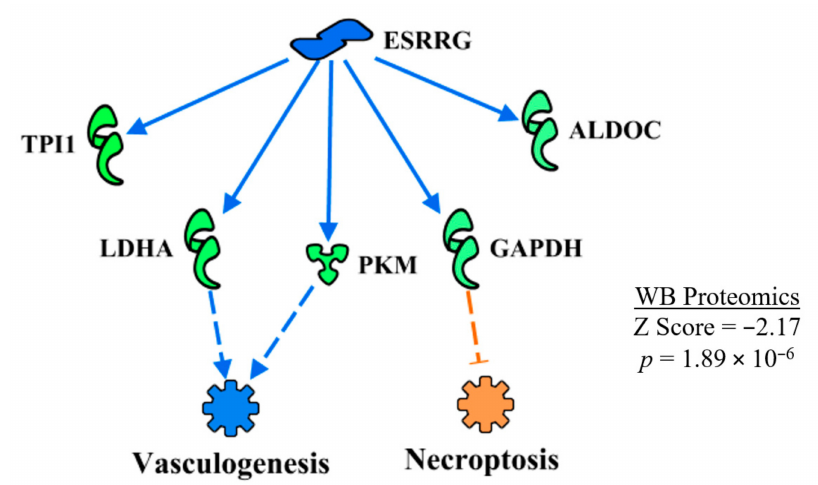
Figure 12. ESRRGamma (ESRRG or ESSR γ ) was predicted to be inhibited in WB myopathy based on the expression of downstream molecules shown in this regulatory network. The regulatory network resulted in the prediction of the inhibition of vasculogenesis and activation of necroptosis. As in Figure 9, discrepancies in the predictions of these functions and those in Table 2 are due to a smaller subset of proteins in the ERRG upstream regulatory network, compared to the larger set of proteins listed for functions in Table 2. Protein abbreviations are defined and differential expression of proteins are provided in Supplementary Table S1.